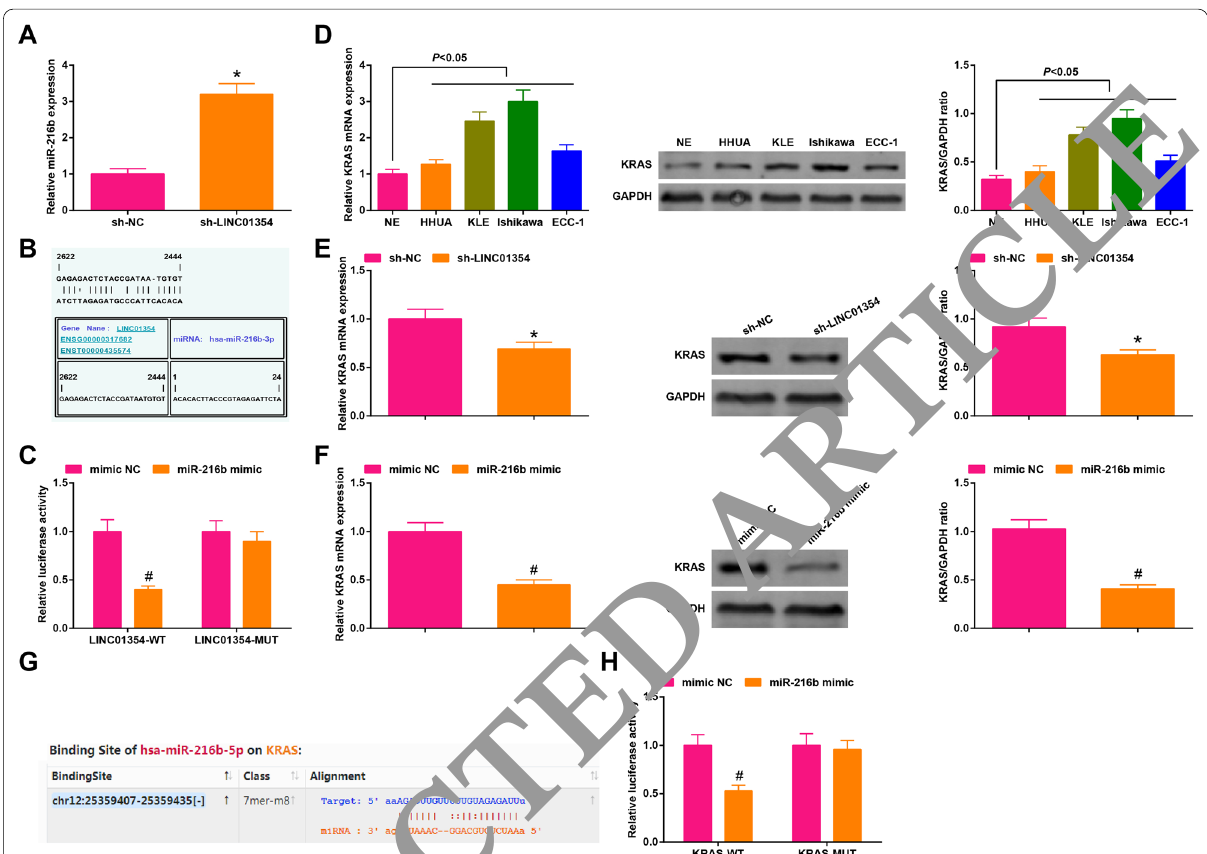
Fig. 4 LINC01354 counteracts with miR-216b to target KRAS. a miR-216b expression was promoted in lshikawa cells by sh-LINC01354 transfection (RT-qPCR); b LINC01354 had binding sites with miR-216b on the Jefferson website; c LINC01354 bound to miR-216b (dual luciferase reporter gene assay); d KRAS expression was high in EC cells versus NE cells (RT-qPCR and Western blot); e KRAS expression was lowered by sh-LINC01354 transfection in lshikawa cells (RT-qPCR and Western blot); f KRAS expression was depressed by miR-216b mimic transfection in lshikawa cells (RT-qPCR and Western blot); g miR-216 had targeting sites with KRAS through the website http:// starb ase. sysu. edu. cn/; H. miR-216b targeted KRAS (dual luciferase reporter gene assay). The data were expressed as mean standard deviation ( N 3). * P < 0.05 versus the sh-NC group; # P < 0.05 ± = versus the mimic NC